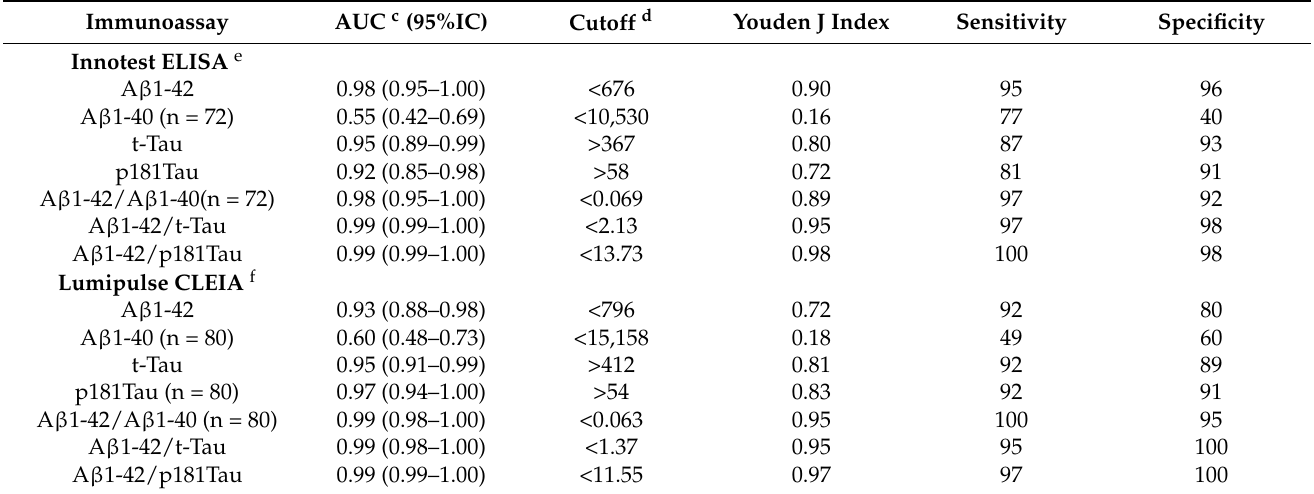
Figure 1. ROC analysis compared to clinical diagnosis as specified in Study 1. ( A ). For each CSF biomarker measured with CLEIA. ( B ). For each CSF biomarker ratio measured with CLEIA. ( C ). For each CSF biomarker measured with ELISA. ( D ). For each CSF biomarker ratio measured with ELISA. Abbreviations: AUC: area under the curve; CLEIA, CSF, ELISA, ROC. Table 2. ROC a analysis of CSF b biomarkers for distinguishing AD from amyloid-negative